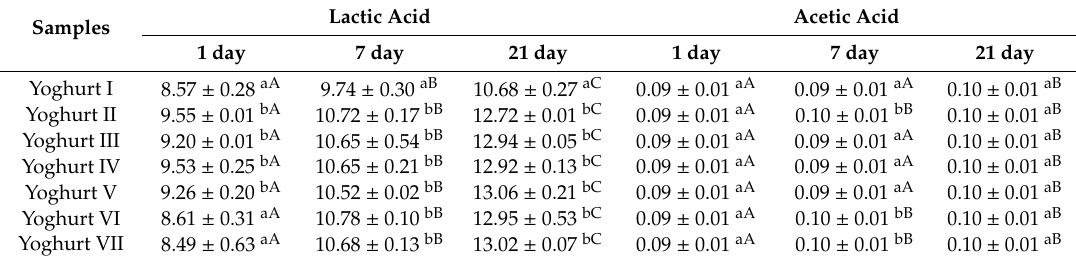
Table 2. Lactic and acetic acids contents (g / kg) of Yoghurts I − VII during their storage at 4 ◦ C. Lactic Acid Acetic Acid Samples 1 day 7